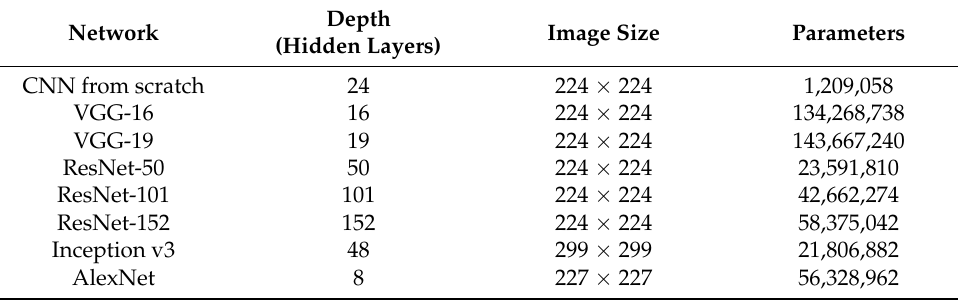
Table 1. Characteristics of the CNNs’ architectures used in this study.